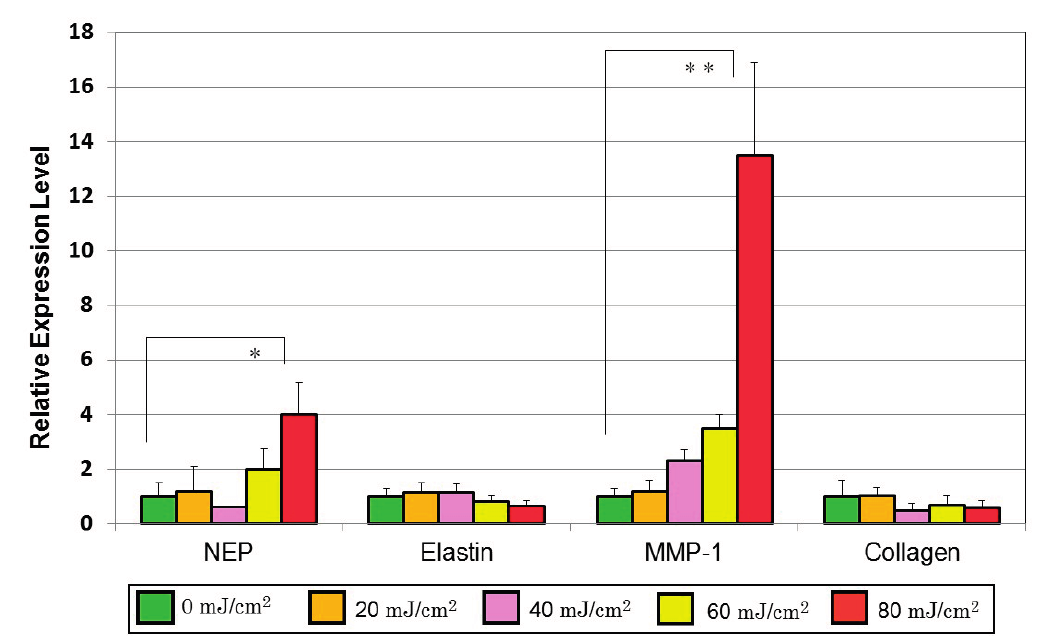
Figure 3. Effects of conditioned medium from UVB-exposed human primary keratinocytes on mRNA levels of neprilysin, elastin, collagenase I (MMP-1) and collagen in human dermal fibroblasts as revealed by real-time RT-PCR analysis. The conditioned medium from UVB-exposed keratinocytes was added at a 1:1 dilution to fibroblasts to measure expression levels of each mRNA at 4 h post-incubation. Values are means ± S.D. derived from three independent experiments. * p < 0.05, ** p <